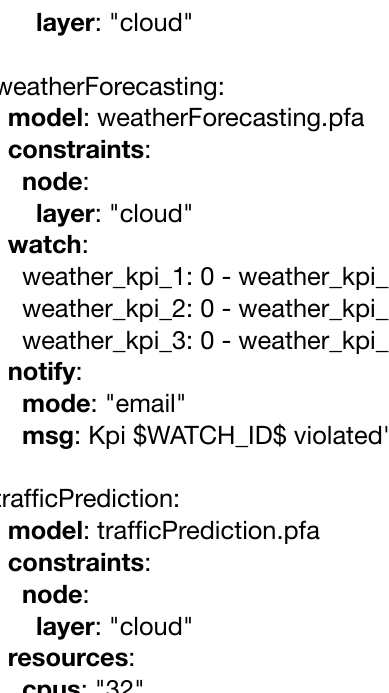
Figure 23. PADL document definition for the flood control usecase for the cloud computing